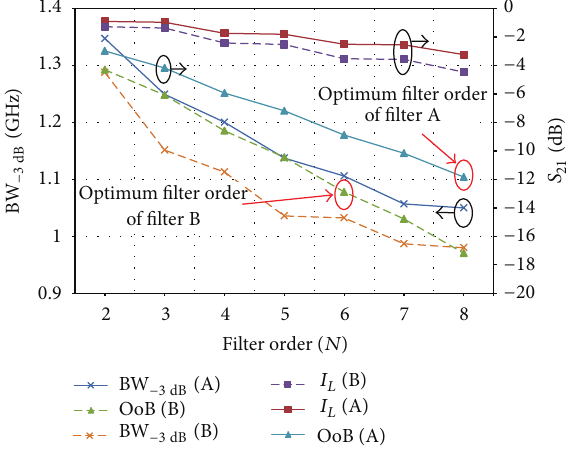
Figure 8: Characteristics of Ku-band FBAR filters. 𝑝 of 𝑓 𝑠 𝑠 , 𝑓 𝑝 𝑠 , 𝑓 𝑠 𝑝 , and 𝑓 𝑝 but different values of